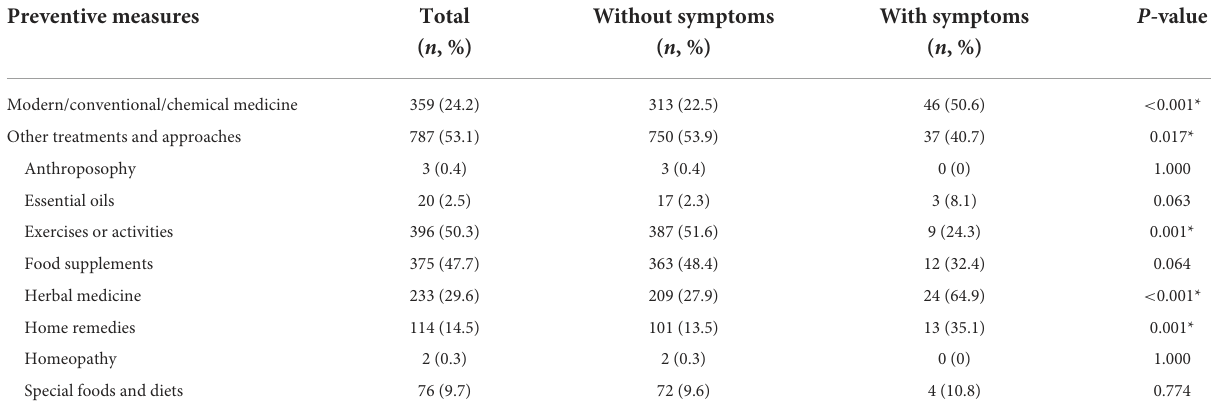
TABLE 2 Preventive approach used by survey